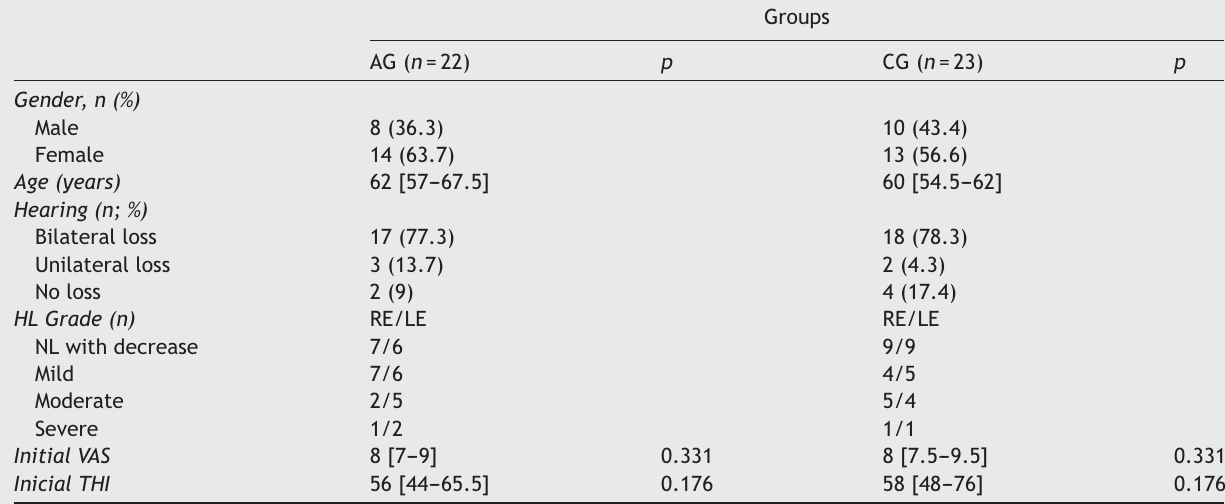
Characteristics of the participants assessed before treatment.